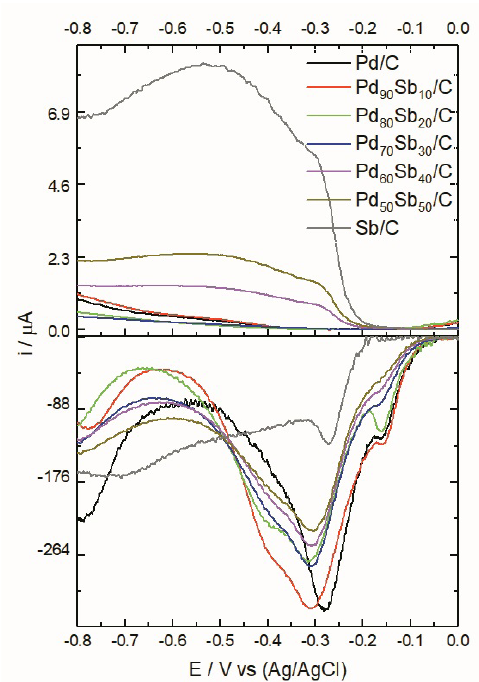
Figure 4. RRDE voltammograms at 1600 r.p.m. in O electrolyte with the disc current with v = 10 mV s -1 , ring current (polarized at 0.2V) corresponding to hydrogen peroxide detection.